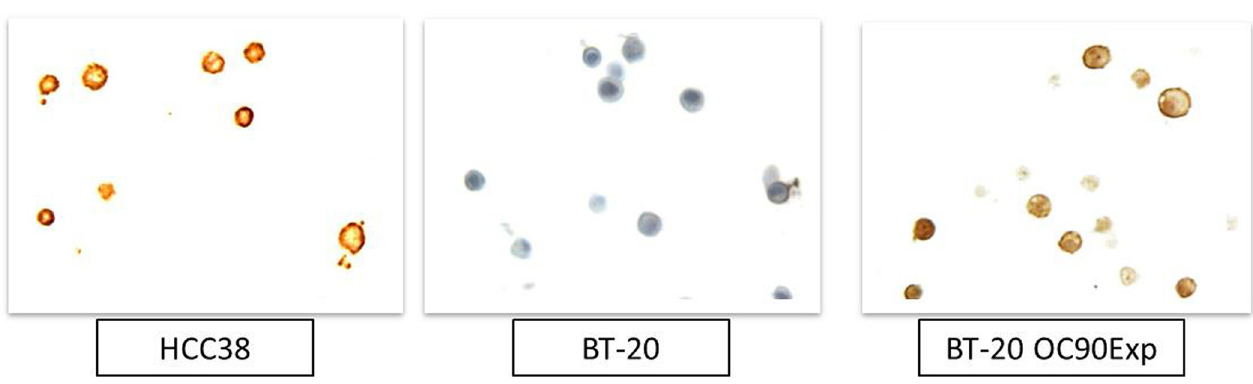
Fig 6. Cell membrane localization of OC90. Antibody staining of endogenous OC90 protein in HCC38 and BT-20 and BT-20 cells overexpressing OC90.